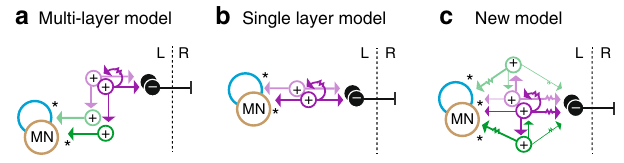
Fig. 8 Circuit models to explain adjustments in timing and amplitude. a Predicted connectivity patterns for type I (purple) and II (green) V2a neurons in a multi-layer model for differential control of the timing and amplitude of activity in epaxial (blue) and hypaxial (brown) motor pools. Arrows are glutamatergic connections and the resistor symbol denotes electrical coupling. L left side, R right side. b as in panel a , but the predicted connectivity patterns of V2a neurons according to single layer models. c as in panel a , but the connectivity pattern revealed in this study in zebra fi sh. Larger arrows/lines indicate stronger